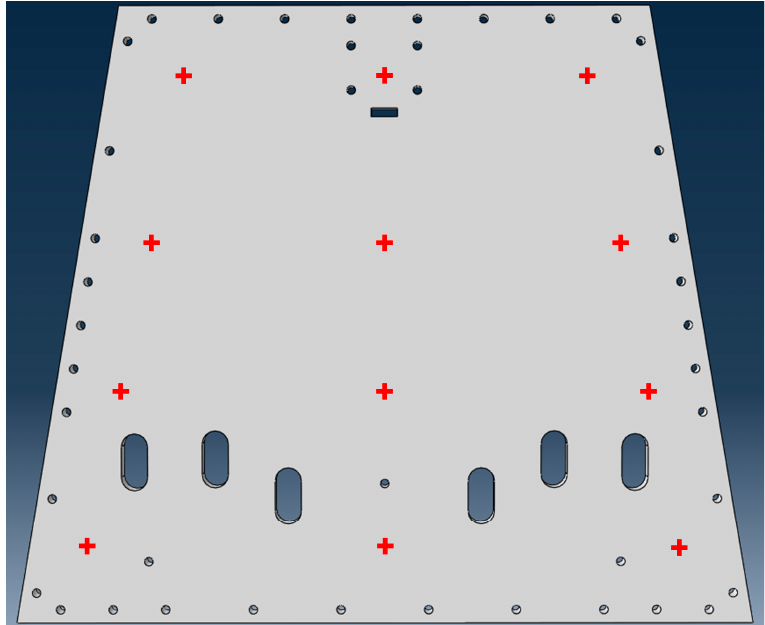
Figure 12. The results of the initial finite element model (unit: mm) ( a ) X-direction ( b ) Y-direction ( c ) Z-direction.